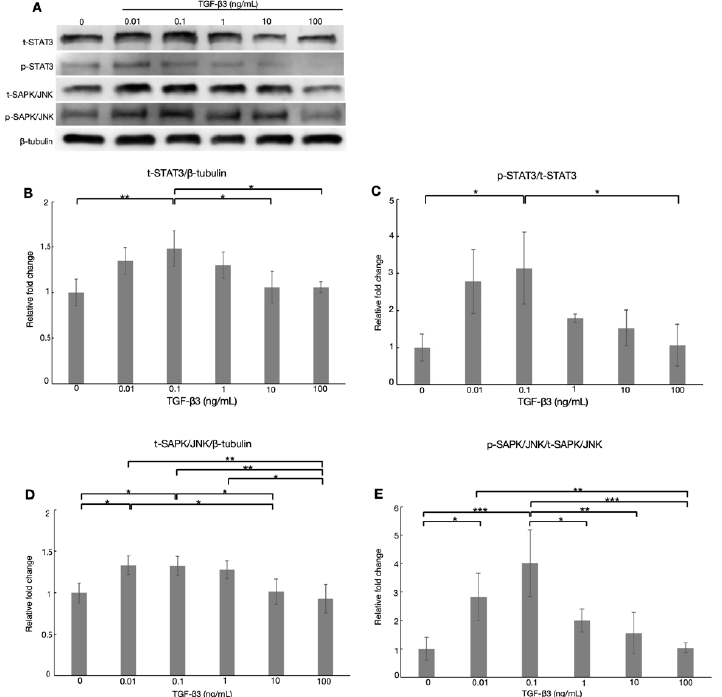
Figure 3. Western blotting of TGF- β3 , statuses of signal transducer and activator of transcription 3 (STAT3), and stress-activated protein kinase (SAPK)/Jun amino terminal kinase (JNK) in HTM cells. Representative bands for STAT3 and SAPK/JNK are shown in ( A ). The total (t)-STAT3/ β -tubulin ratio ( B ) and phosphorylated (p)-STAT3/t-STAT3 ratio ( C ) in HTM cells were significantly increased after treatment with 0.1 ng/mL TGF- β 3 compared to controls, while the ratio was significantly decreased by treatment with 100 ng/mL TGF- β3 in comparison to 0.1 ng/mL TGF- β3 . The t-SAPK/JNK/β -tubulin ratio ( D ) and p-SAPK/JNK/t-SAPK/JNK ratio ( E ) were significantly enhanced after treatment with 0.01 and 0.1 ng/mL TGF- β3 compared to controls. However, the ratio was significantly reduced by treatment with 10 and 100 ng/mL TGF- β3 in comparison to 0.1 ng/mL TGF- β3 . The results are expressed relative to the loading control ( β -tubulin). * p < 0.05, ** p < 0.01, *** p < 0.001, n = 5.